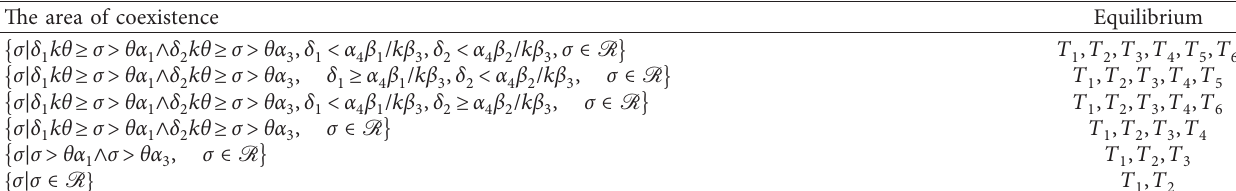
to T of System 1 6